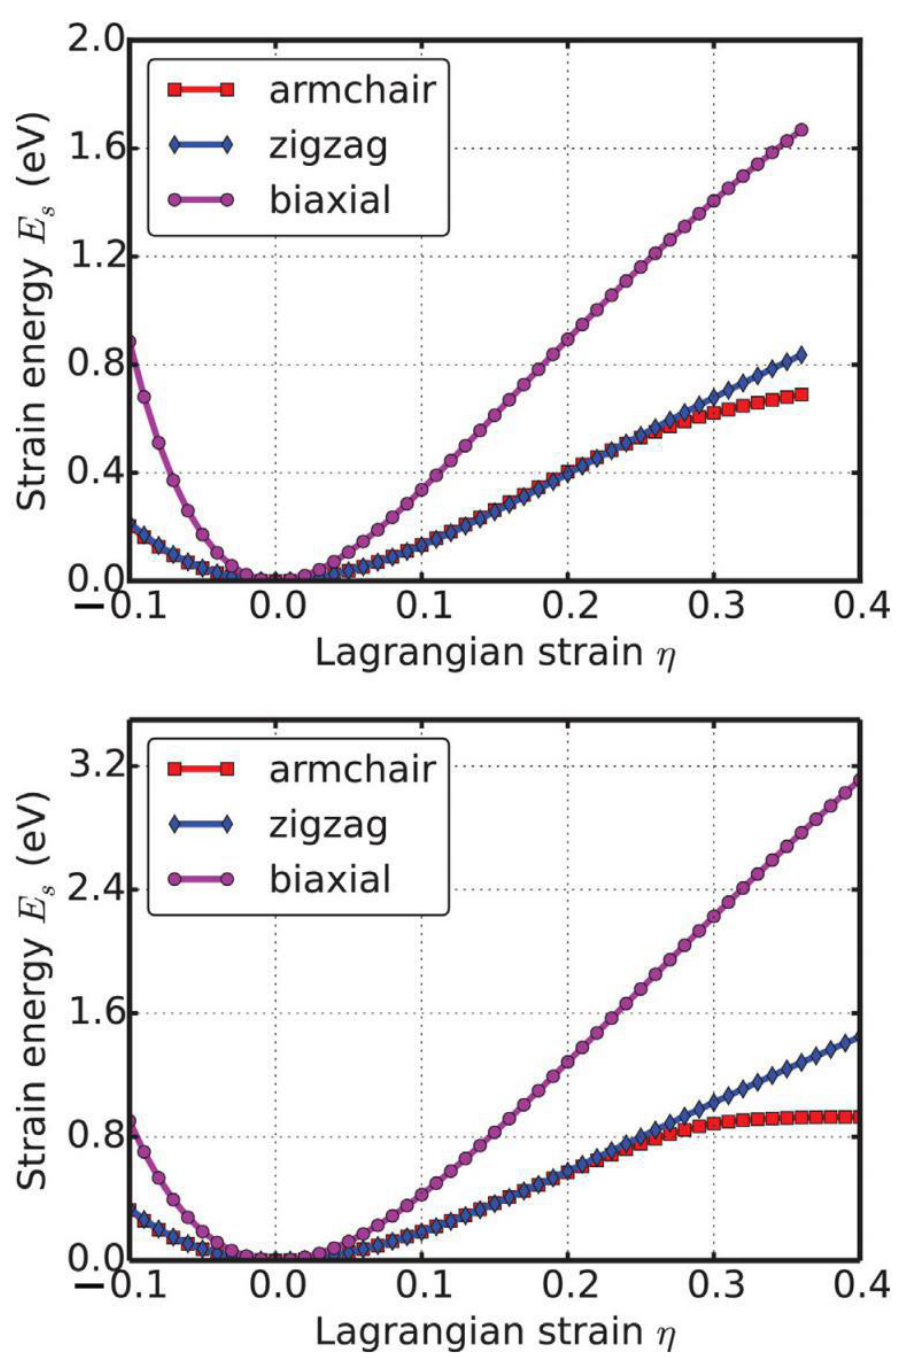
Figure 18. Energy–strain responses for uniaxial strain in armchair and zigzag directions, and equibiaxial strains of g-InN ( top ), compared with g-BN ( bottom ).